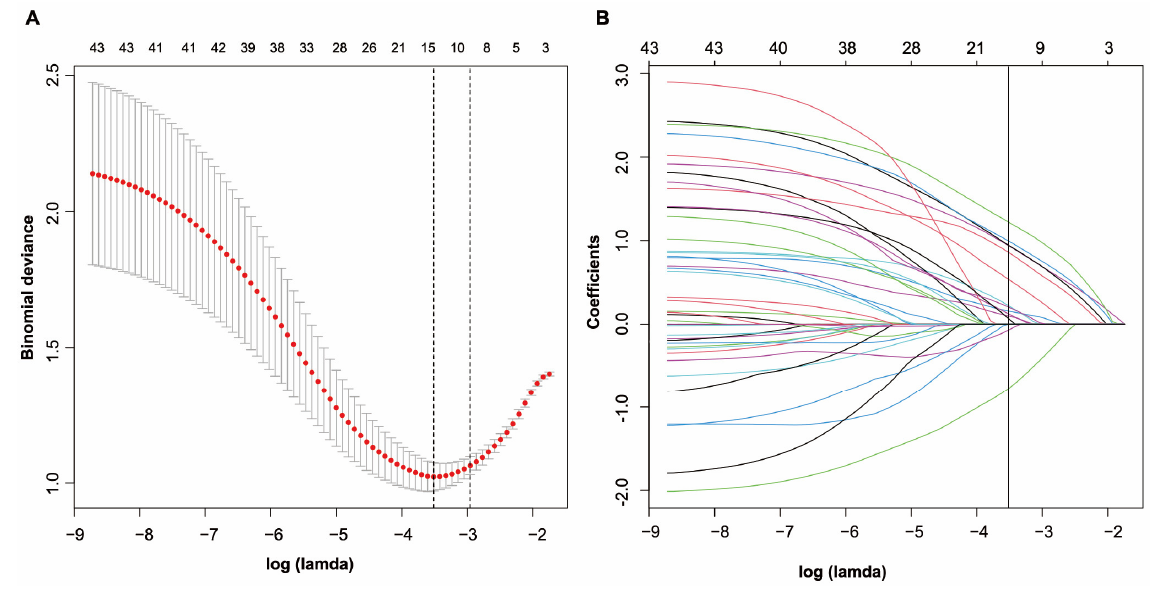
Figure 1. Selection of demographic and clinical features using LASSO binary logistic regression. ( A ) In the LASSO model, an optimal parameter (lambda) was selected using five-fold cross-validation based on minimum criteria. An image of the partial likelihood deviance (binomial deviance) curve was plotted against log (lambda). Based on the minimum criteria as well as 1 SE from the minimum criteria, dots were drawn on the vertical axis corresponding to the optimal values. ( B ) LASSO coefficient profiles of the 43 features. A coefficient profile plot was produced against the log (lambda) sequence. A vertical line was drawn at the value selected using fivefold cross-validation, where the optimal lambda resulted in fifteen features with nonzero coefficients. Abbreviations: LASSO (least absolute shrinkage and selection operator); SE (standard error).